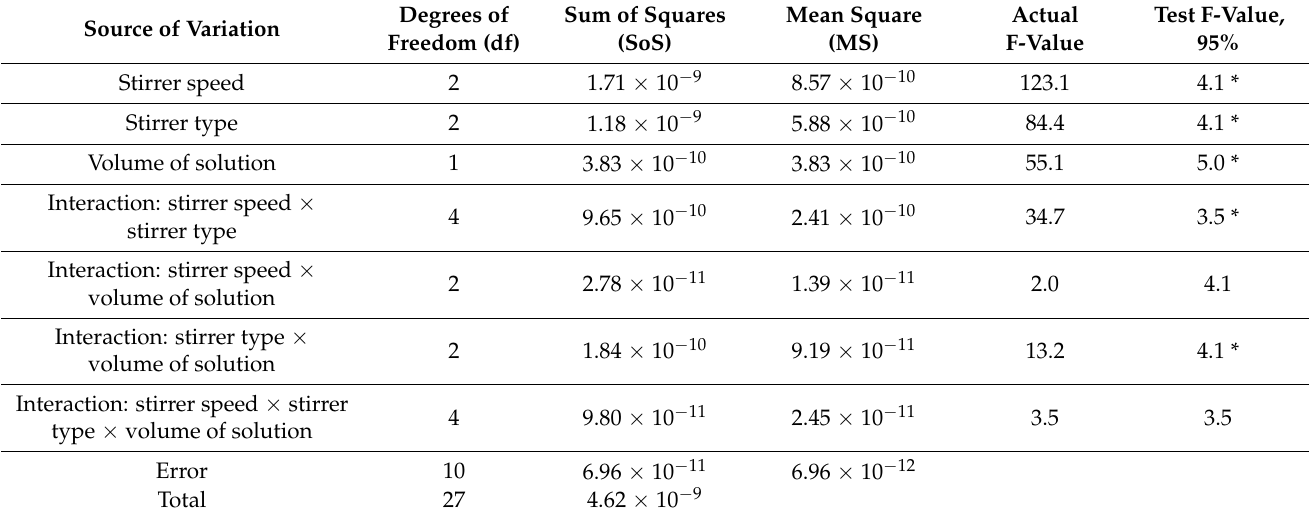
Table 3. ANOVA for the mass-transfer coefficients from the 13 mm platform, beaker, and stirrer (* means significant at 95% confidence level).